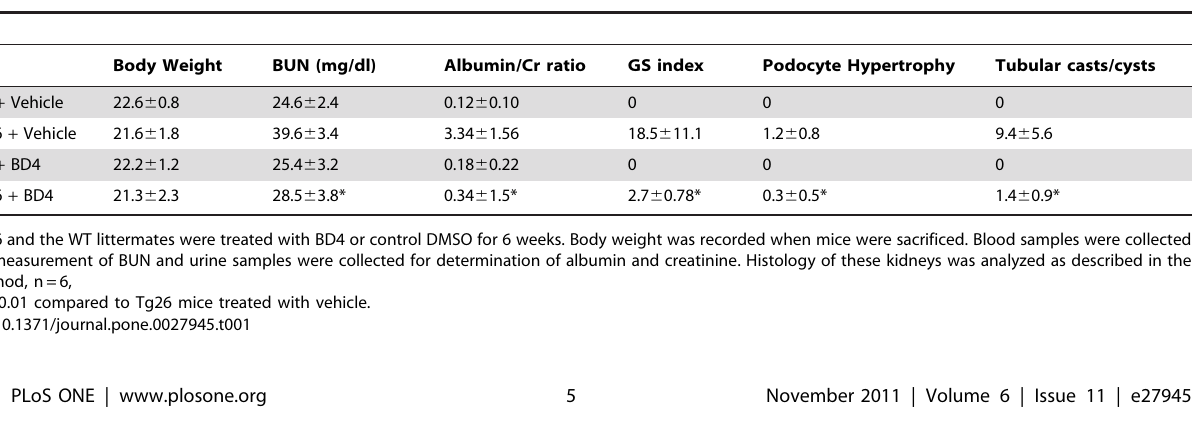
Table 1. Effects of BD4 on mouse body weight, BUN, proteinuria, and kidney